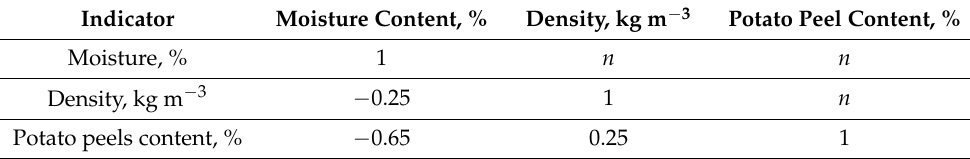
Table 4. Correlation between moisture content and potato peel content in